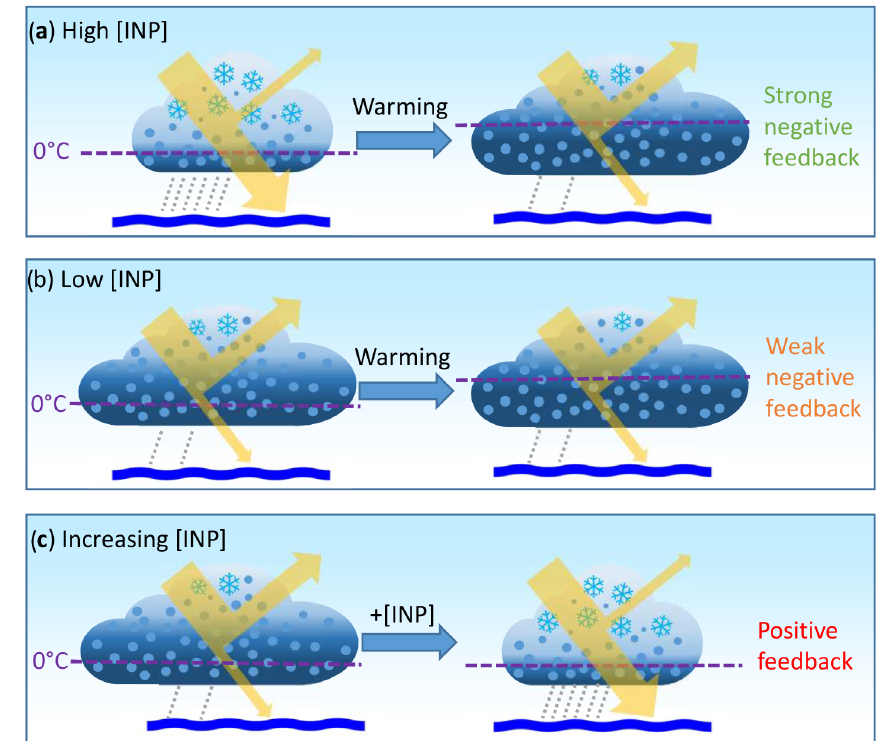
Figure 3. Cartoons illustrating how the response of mixed-phase clouds to a changing climate is controlled by the ice-nucleating particle concentration. (a) With a relatively high INP concentration ([INP]), there is a large potential for liquid to replace ice as climate warms and isotherms shift upwards, resulting in a strong negative shortwave feedback. (b) With a relatively low INP concentration, clouds contain relatively little ice in the present climate, so there is less ice to replace with liquid water and a relatively small negative feedback. (c) Setting the temperature changes aside, there may be either increases or decreases in INP concentration in the future that clouds will respond to. We have shown the effect of an increase in INP concentration where we would expect a decrease in liquid water path and a positive